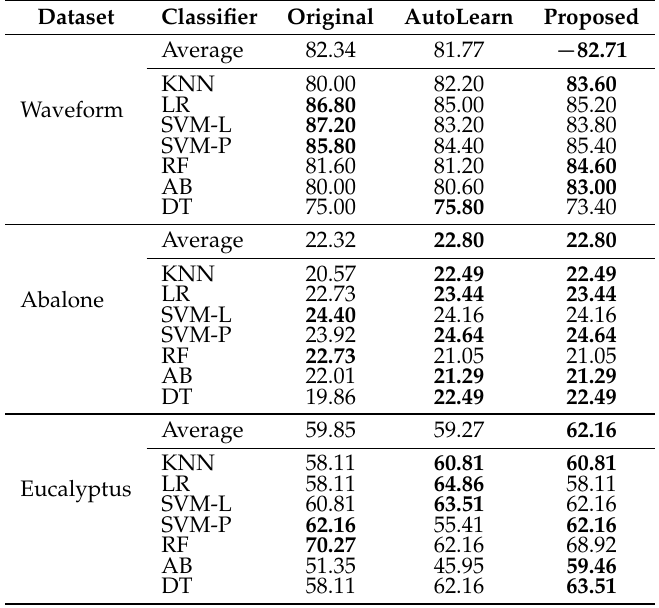
Table 8. Performance comparison in terms of classification accuracy